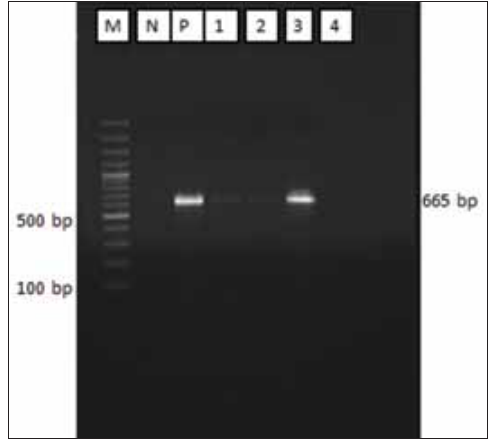
Figure-1: Agarose gel electrophoresis (1.0%) showing amplicons of 665 bp for Theileria equi . Lane M: 100 bp deoxyribonucleic acid (DNA) ladder/marker; Lane N: Non- template control; Lane P: Positive control; Lane 1-4: Tick DNA